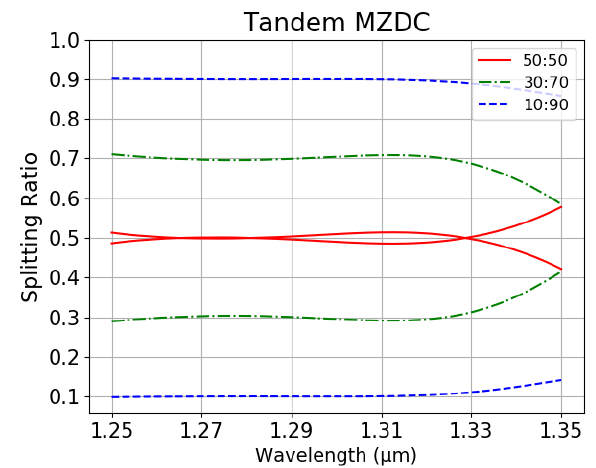
Figure 9. Splitting ratio of Tandem MZDC.